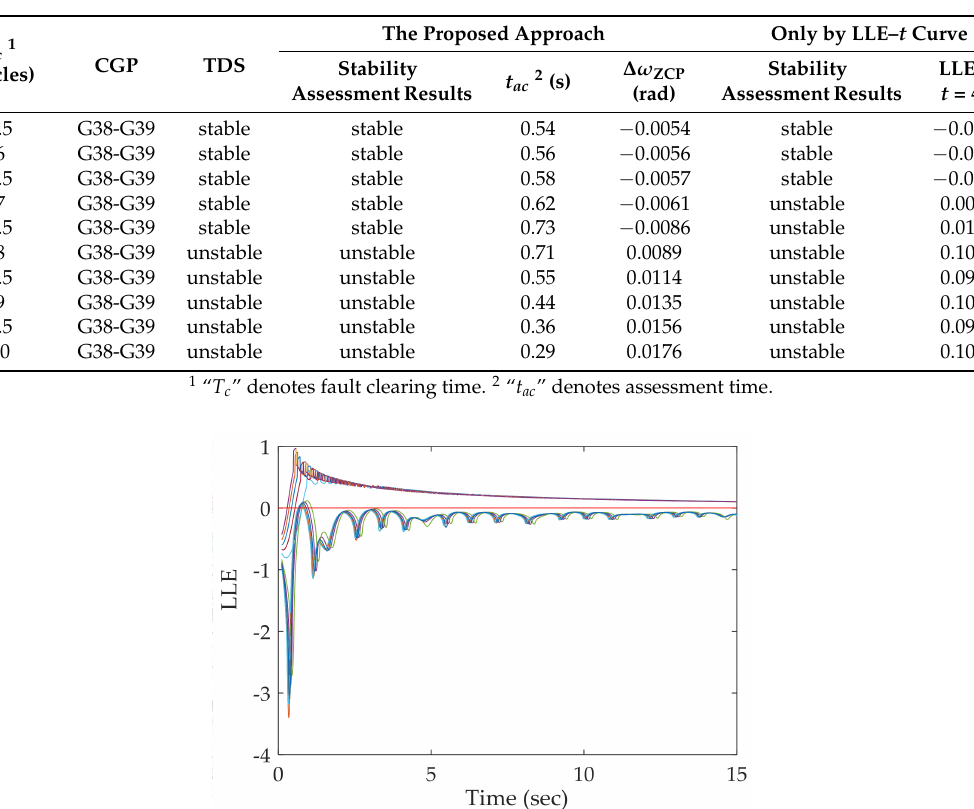
Table 1. The comparisons of the simulation results obtained by different assessment approaches for the IEEE-39 bus system.